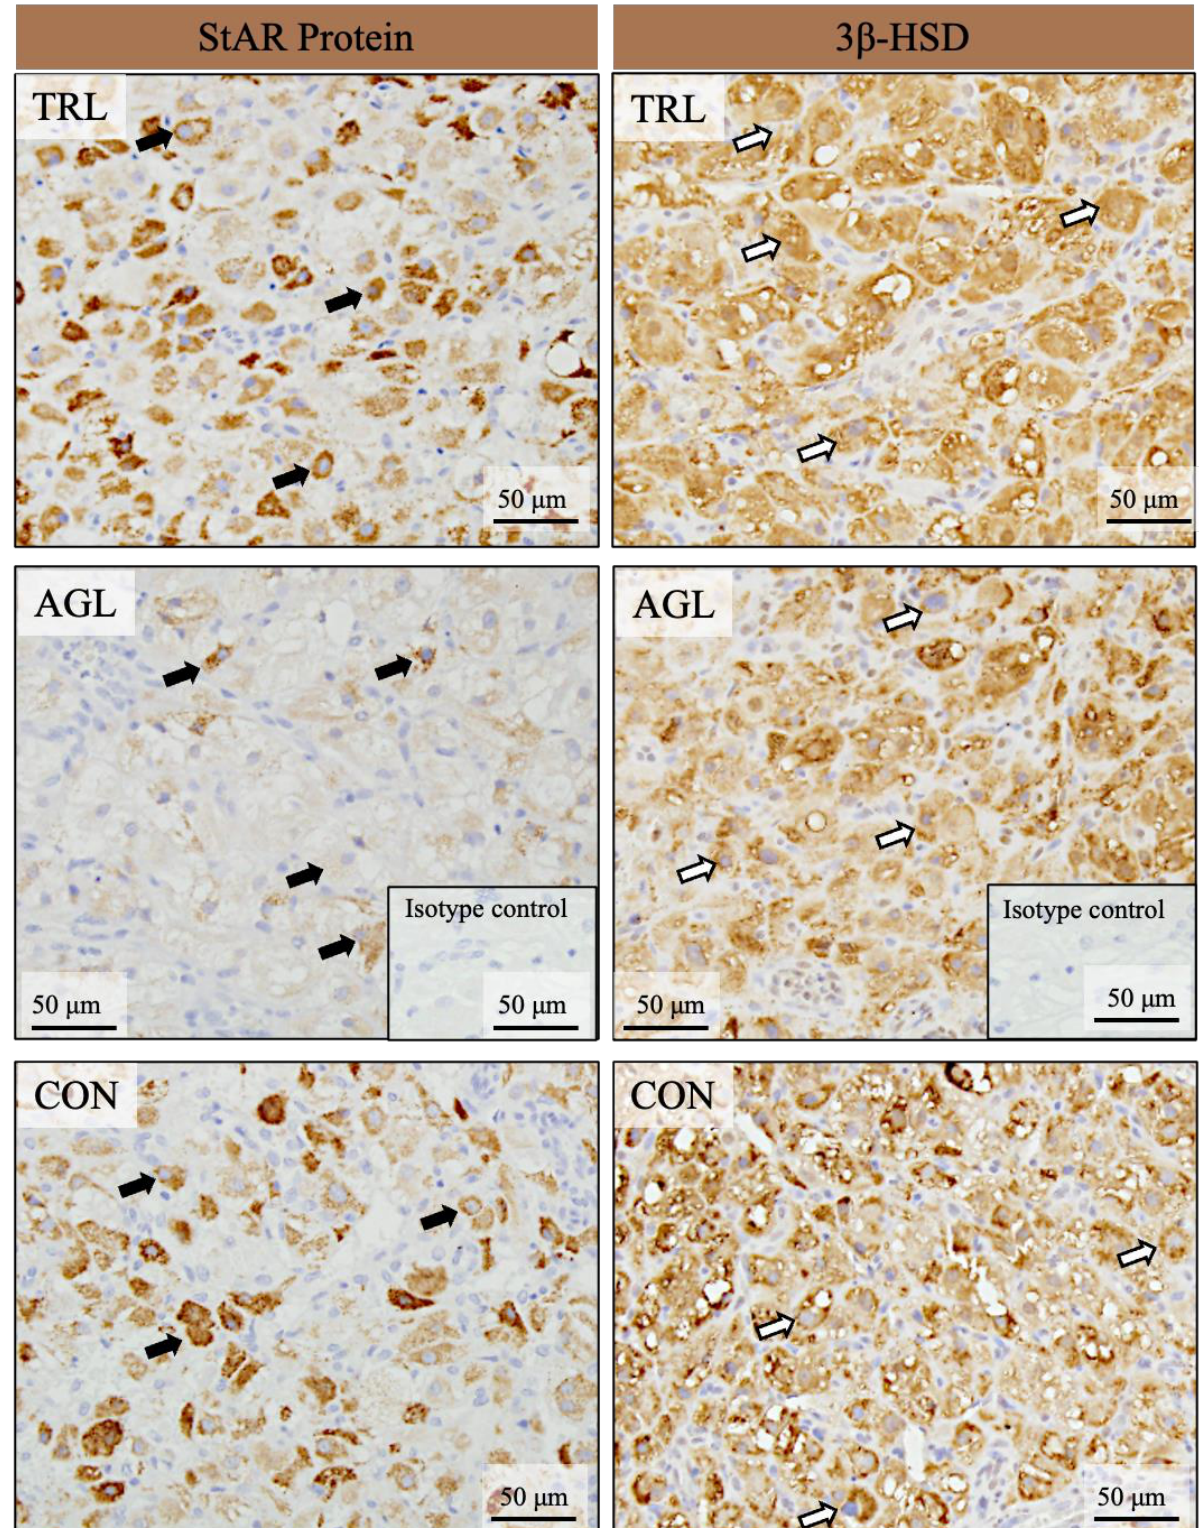
Figure 6. Localization of StAR protein (black arrows in the left column) and 3 β -HSD (white arrows in the right column) in the luteal cells, as demonstrated by immunohistochemical staining. TRL, trilostane; AGL, aglepristone; CON, control.